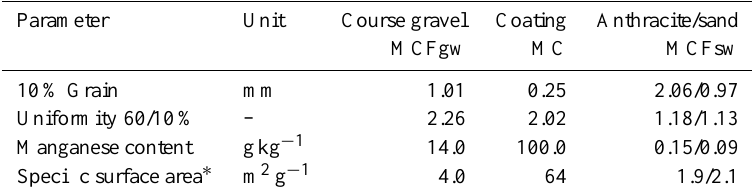
Table 1. Specifications of different tested filter gravels.